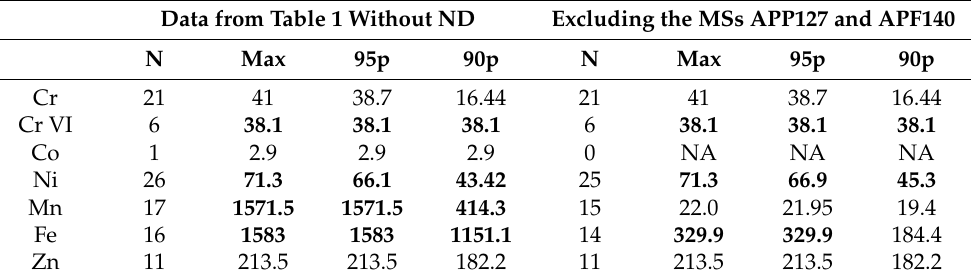
Table 6. PTE percentiles calculated using the representative PTE values (in µ g/L) for each MS (Table 1). In bold, the values exceeding the TVs for water quality [15]. Data from Table 1 Without